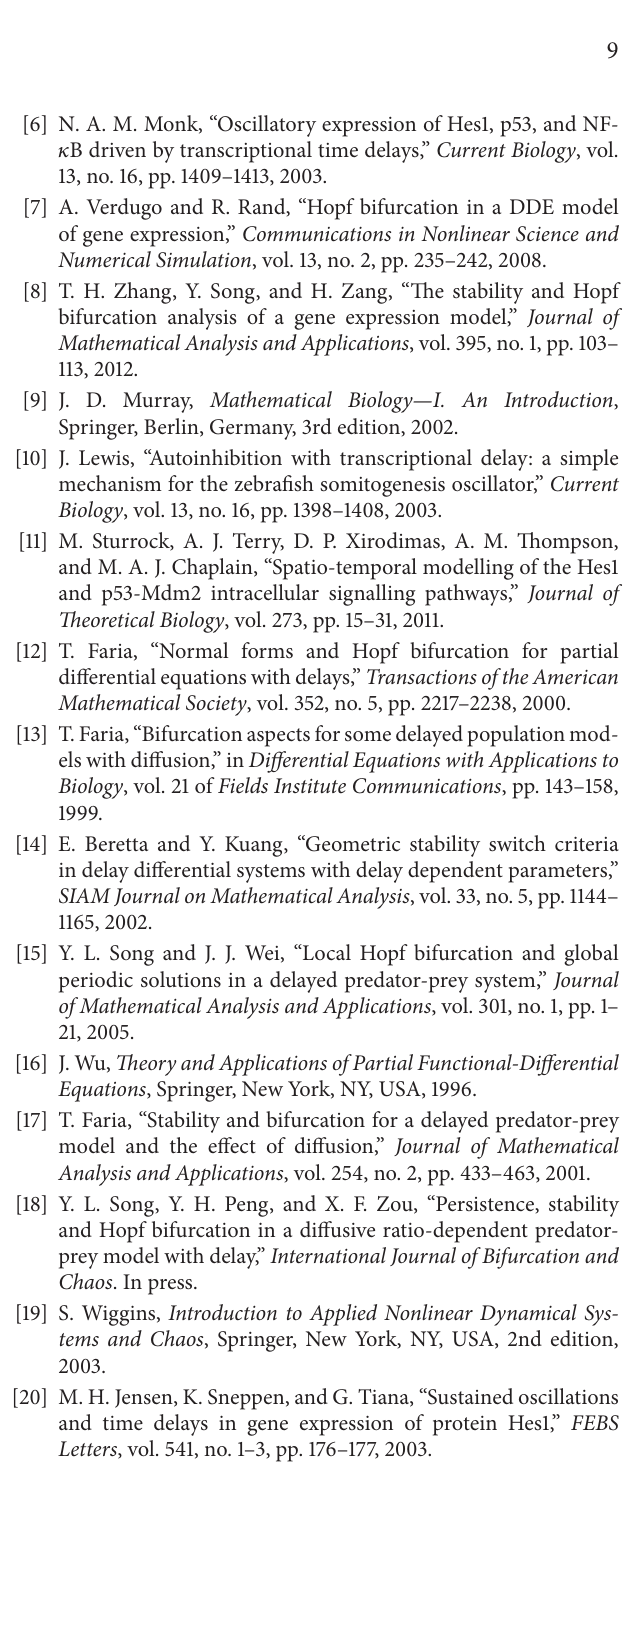
(𝑥) = 0.2+0.1 cos 𝑥 ; and 0